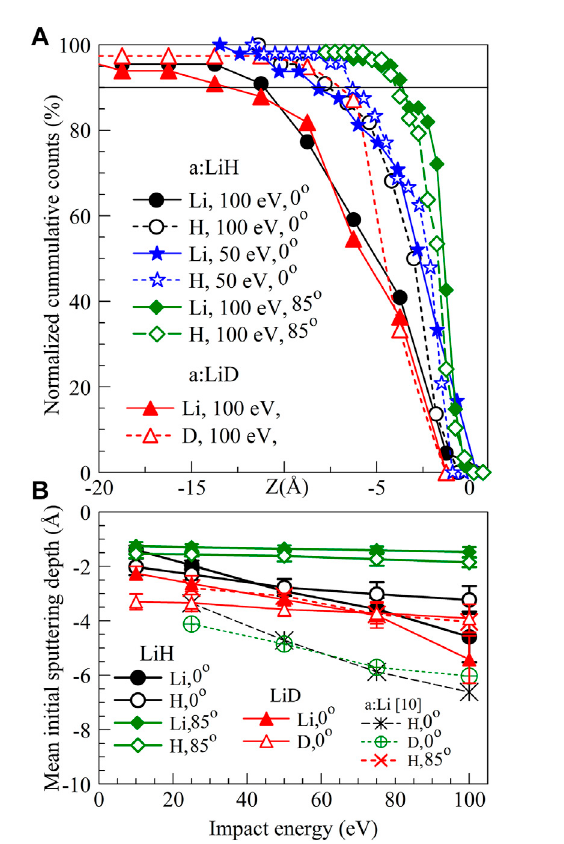
FIGURE 7 Initial sputtering depth of Li and H or D atoms were calculated in an (A) LiH or (A) LiD slab target at 300 K, due to H and D impacts. (A) Distribution of the initial sputtering depths as function of impact energy at incident angles of 0 ° or 85 ° . (B) Impact energy dependence of the mean initial sputtering depths, de fi ned byEq. 2, of Li and H or Datomsin an (A) LiH or (A) LiD slab target for various cases of incident H or D